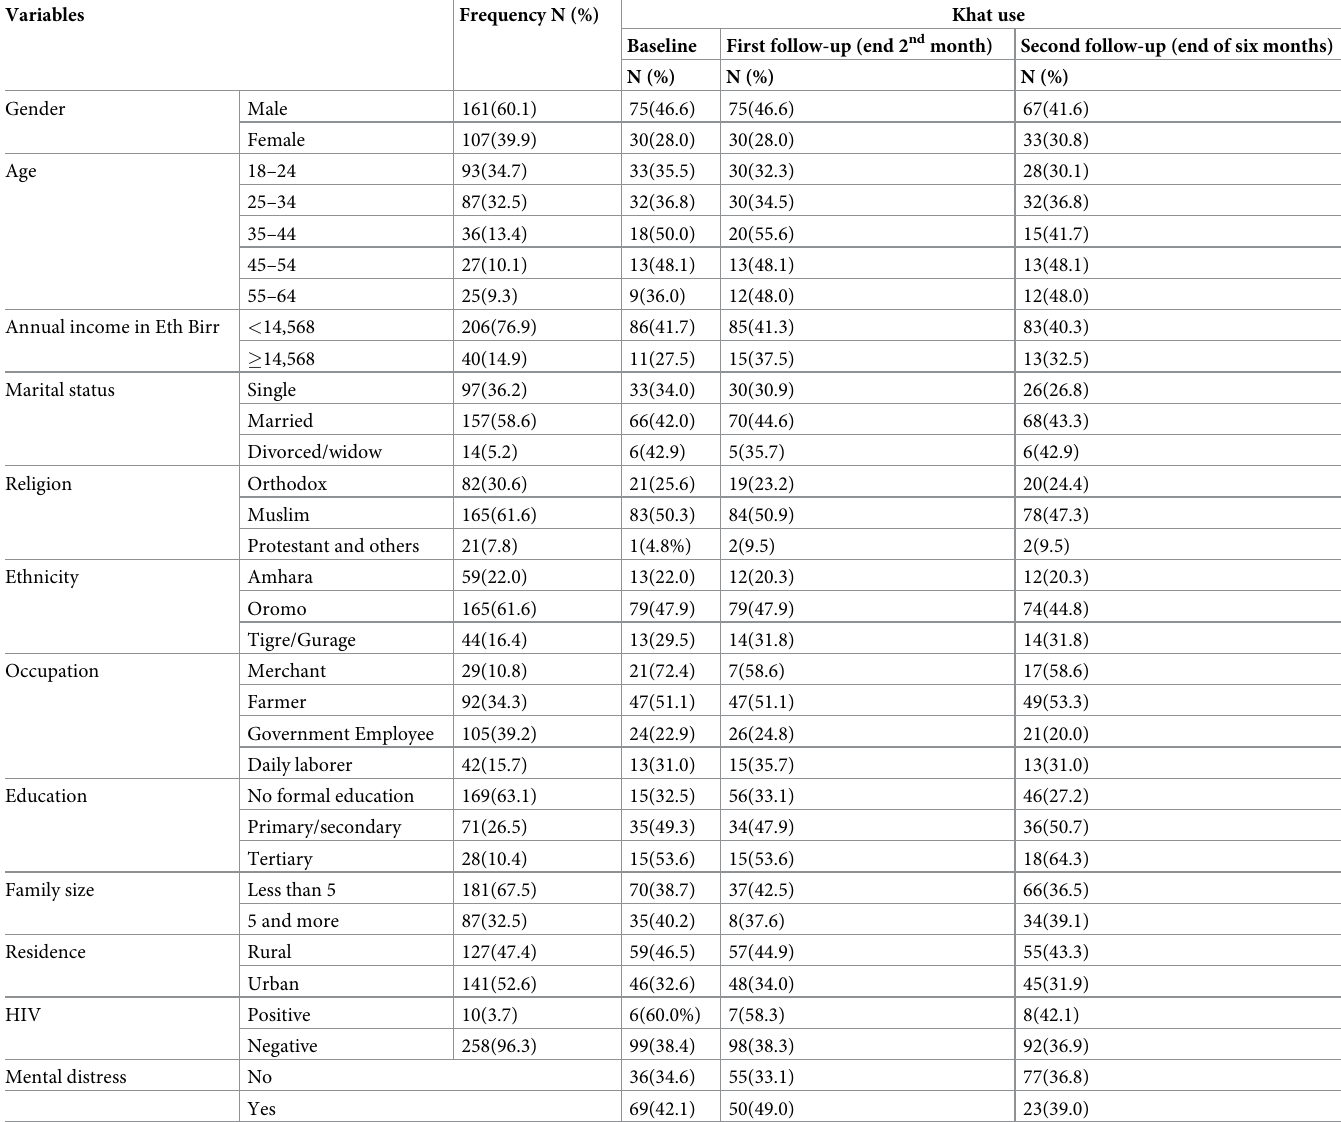
Table 1. Characteristics of patients with tuberculosis in Southwest Ethiopia 2017/18 (n =